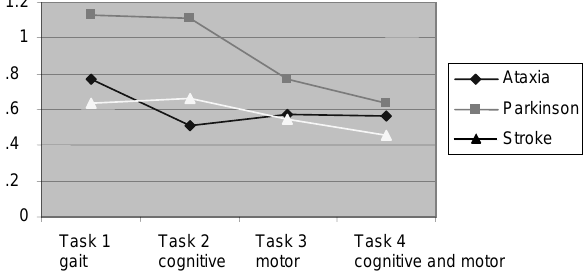
Figure 2 . Median values of the average speed performed by the Ataxia, Parkinson’s and stroke groups tested in the four